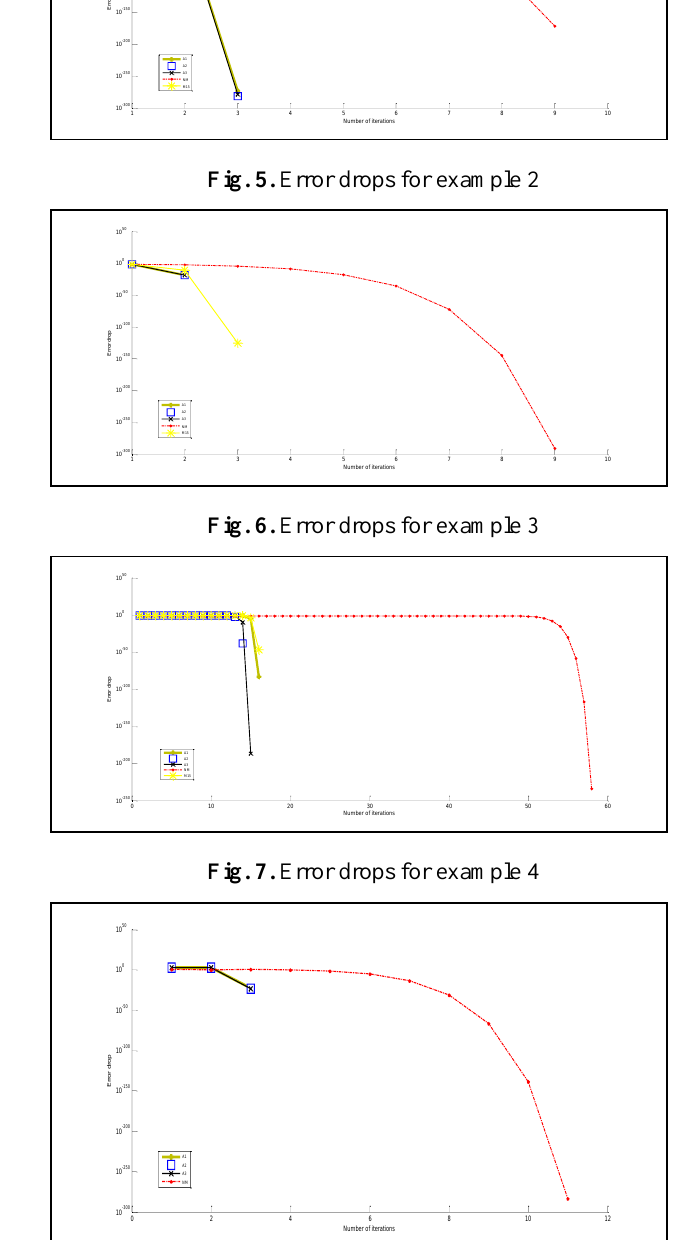
Fig. 8. Error drops for example